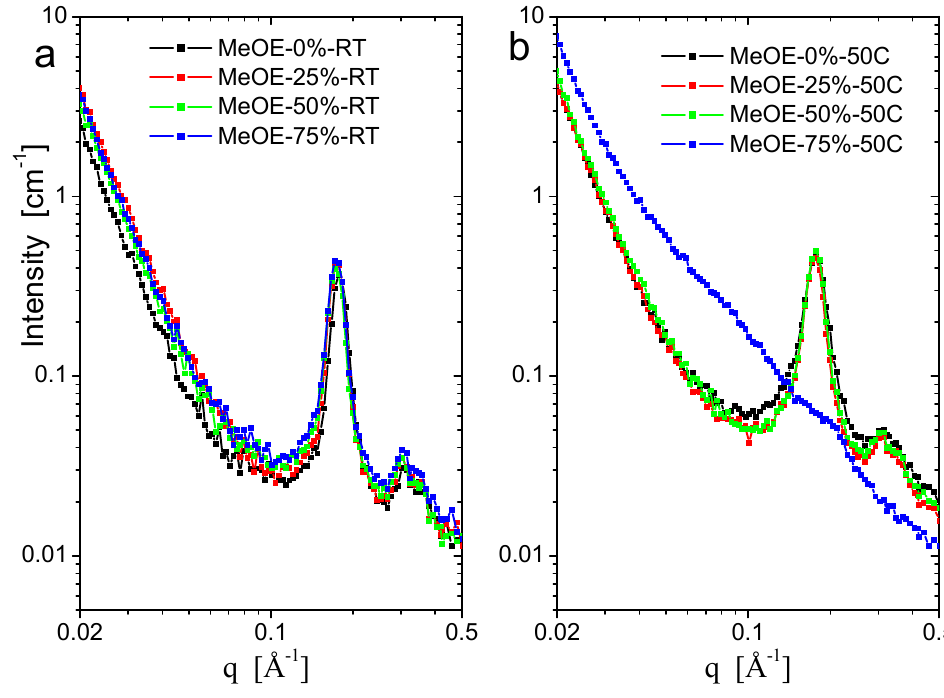
Figure 6. SANS scattering curves of samples prepared at room temperature ( a ) and at 50 °C ( b ).